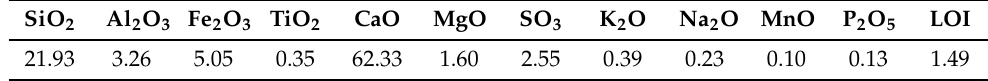
Table 1. Chemical composition of Class G oil well cement